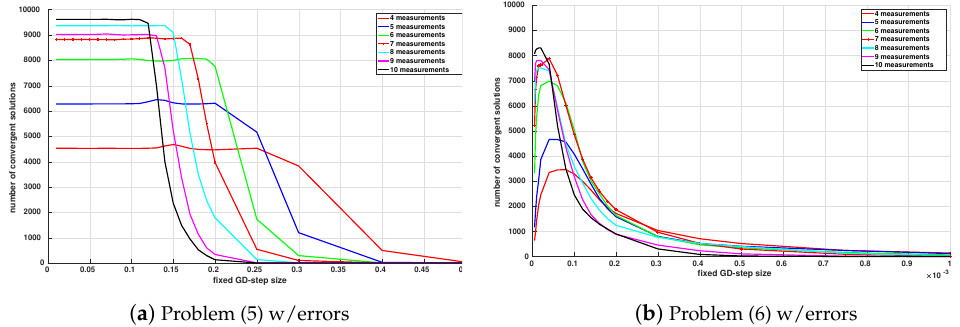
Figure 4. Convergence results on 10,000 simulations using GD with fixed-step descent for estimation problems (5) ( a ) and (6) ( b ), respectively, including position and range measurement error models and by varying the number of neighboring nodes from 4 to 10.